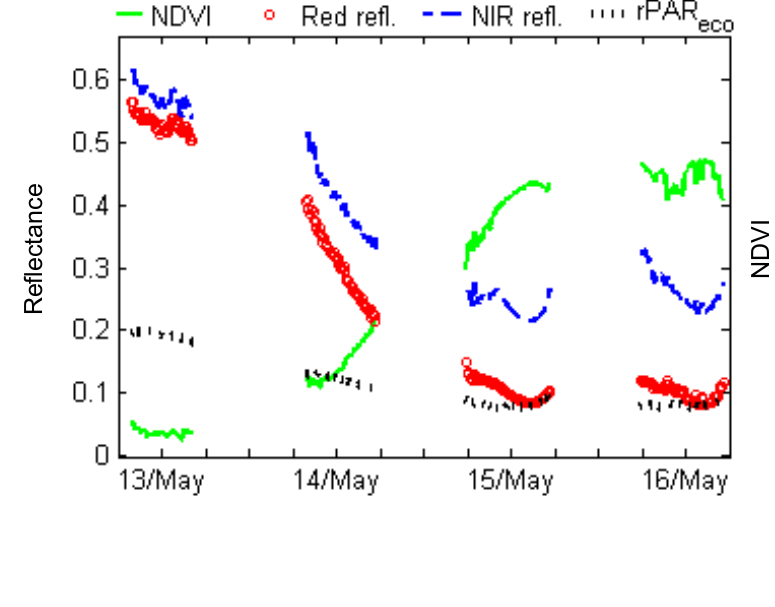
Figure 7. Daily trajectories in reflectance, PAR, and NDVI at Stordalen mire from May 13 (DOY 133) to May 16 (DOY 136). Daily NDVI increased by 0.2 on May 14 and May 15. The reflectance in red, NIR and PAR decreased simultaneously with the largest decrease occurring for the red reflectance. The labels are shown at the 12:00 location of the x-axis, and the tick interval is 6